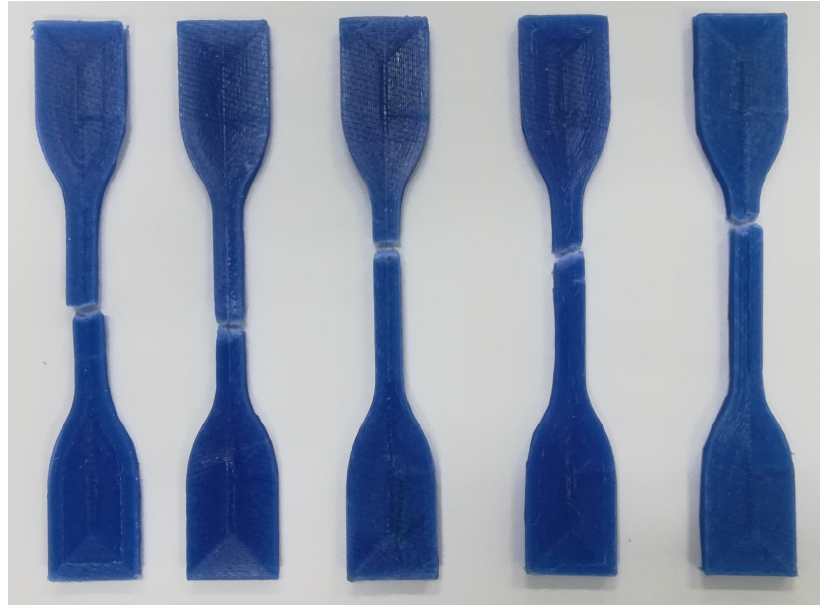
Figure 5. Fractured tensile samples of Wax3D. Table 9. The UTS and Young’s modulus for Wax3D samples.